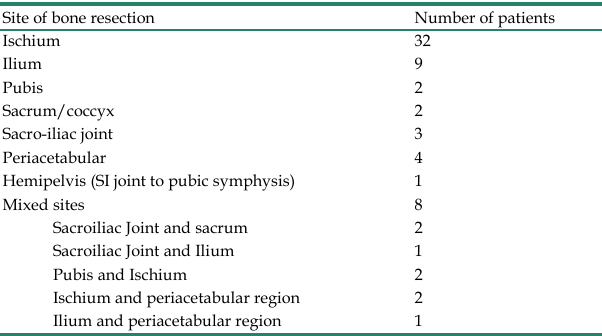
Table 2. Bone or joint excised or resected Site of bone resection